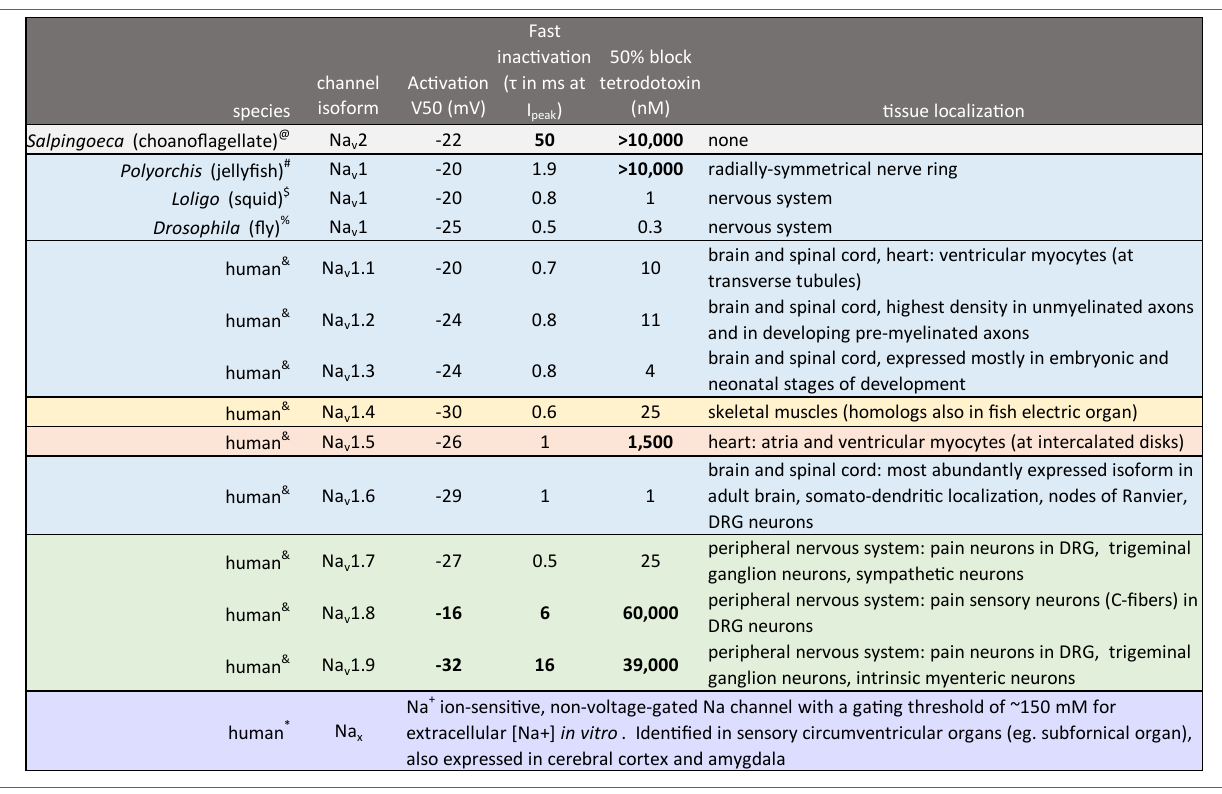
TABLE 2 | Basic characteristics of sample sodium channels including human